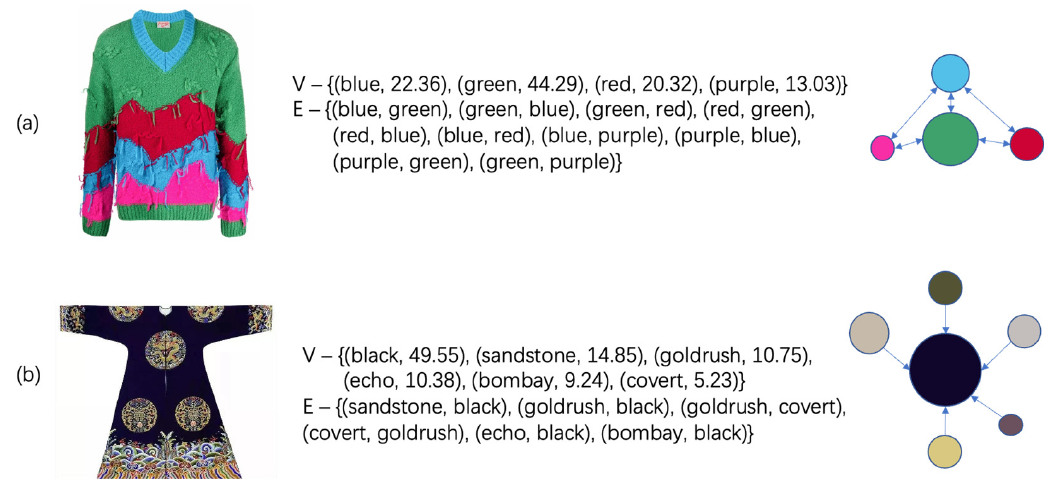
Figure 7. Color graph representation of fashion outfits [22,23]. ( a ) Example fashion outfit with four different colors; ( b ) Example fashion outfit with six different colors.